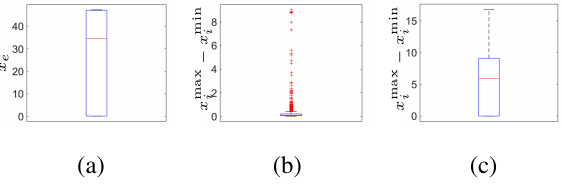
Fig. 5: Box plots of AHL-concentrations under differ- ent conditions. The colours mean the following: red line is the median, blue box is the 25 − 75% -quantile, black limiters (whiskers) extend to the most extreme values √ 1000 · (75% − quantile which are no more than 1 . 57 / − 25% − quantile ) away from the box and red crosses show outliers not belonging to the region limited by the whiskers. (a) Extracellular AHL-concentration within one colony. Each colony had the same amount of regu- lator n l available and the same number of cells. How- ever, the concrete distribution of regulator n l amongst the individuals is different in each colony. The AHL- concentration is measured at the end of the simulation at time t end = 1000 . The values of regulator n l are simulated with E [ N l ] = 6 . 5 and V ar [ N l ] ≈ 5 . 2 . (b) Box plot, where each data point is obtained by subtracting the cell with the lowest intracellular AHL- concentration at the end of the simulation ( t end = 1000 ) from the cell with the highest intracellular AHL- concentration within one colony. The difference of the intracellular AHL-concentration between the cells is - in this subfigure - due to the influence of GroESL on the LuxR-production. One thousand colonies were simulated to create this box plot. E [ N r ] = 6 and V ar [ N r ] ≈ 0 . 055 . (c) Box plot was created in the same way as in (b), only the influence of regulator n l on the LuxI-production is varying this time. E [ N l ] = 6 . 5 and V ar [ N l ] ≈ 5 . 2 . End of simulation at time t end = 1000